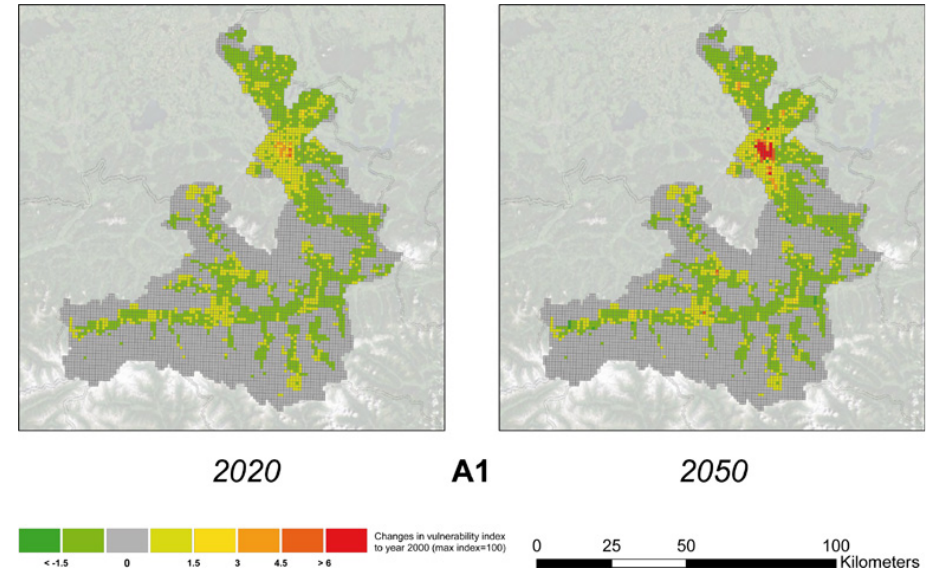
Figure 3. Change of vulnerability value within the A1 scenario to the reference year